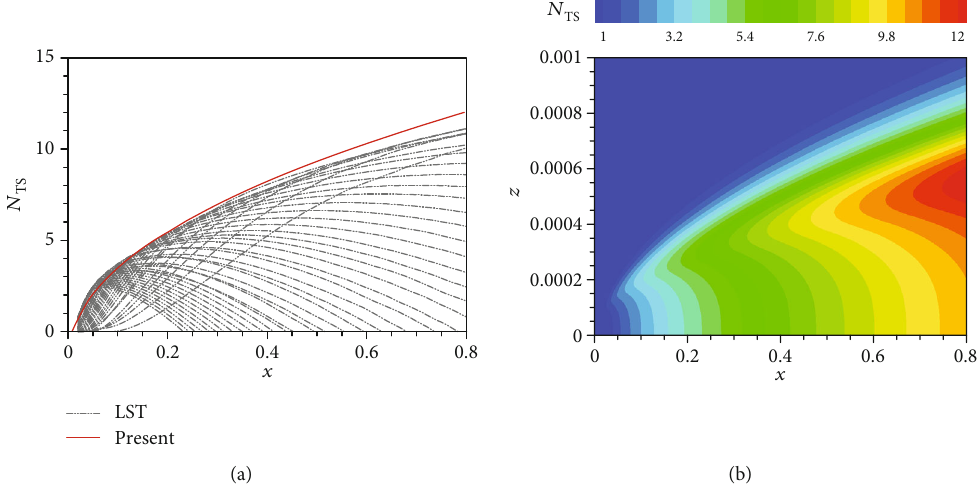
Figure 5: Predicted results of ampli fi cation factor. (a) Comparison with standard LST analysis results. (b) Contour at Mach number = 2 : 2 and Reynolds number = 3 : 0 × 10 7 /m .